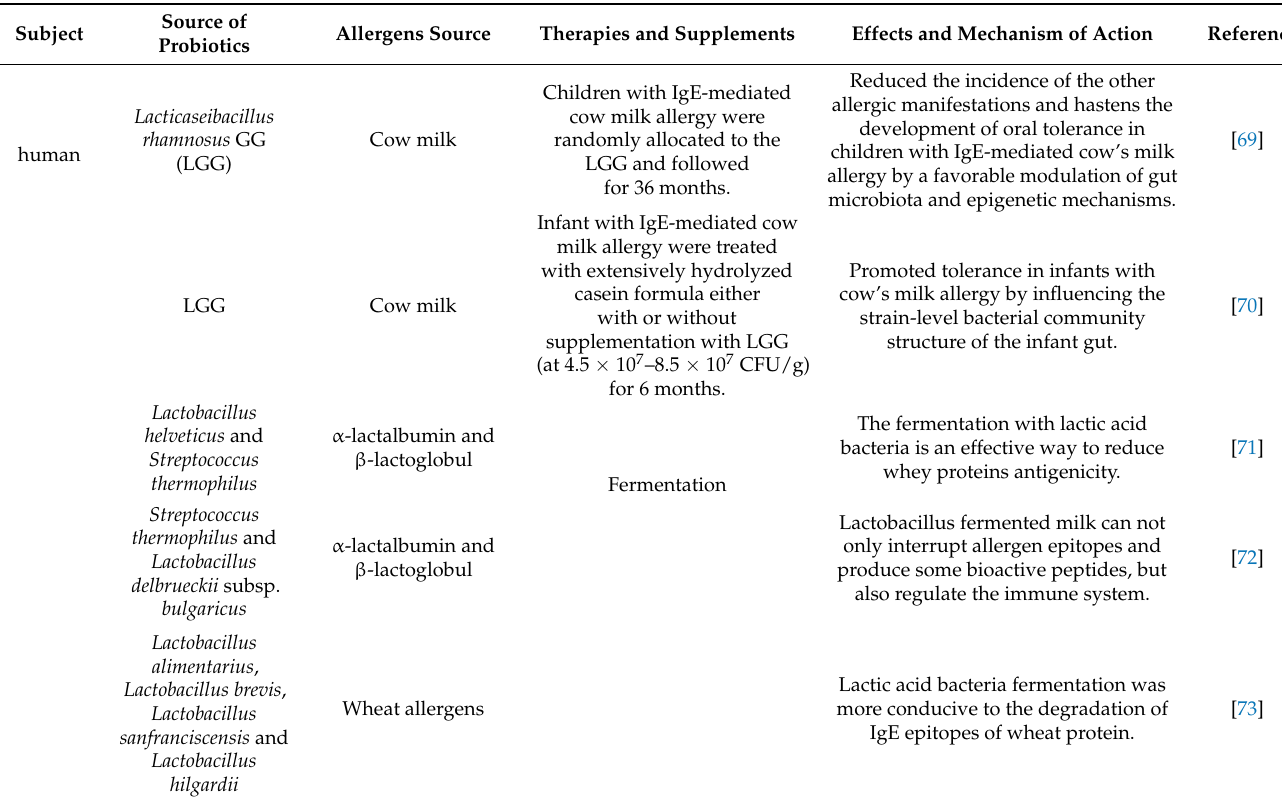
Table 3. Summary of proposed mechanistic actions of the effect that the probiotics has on food